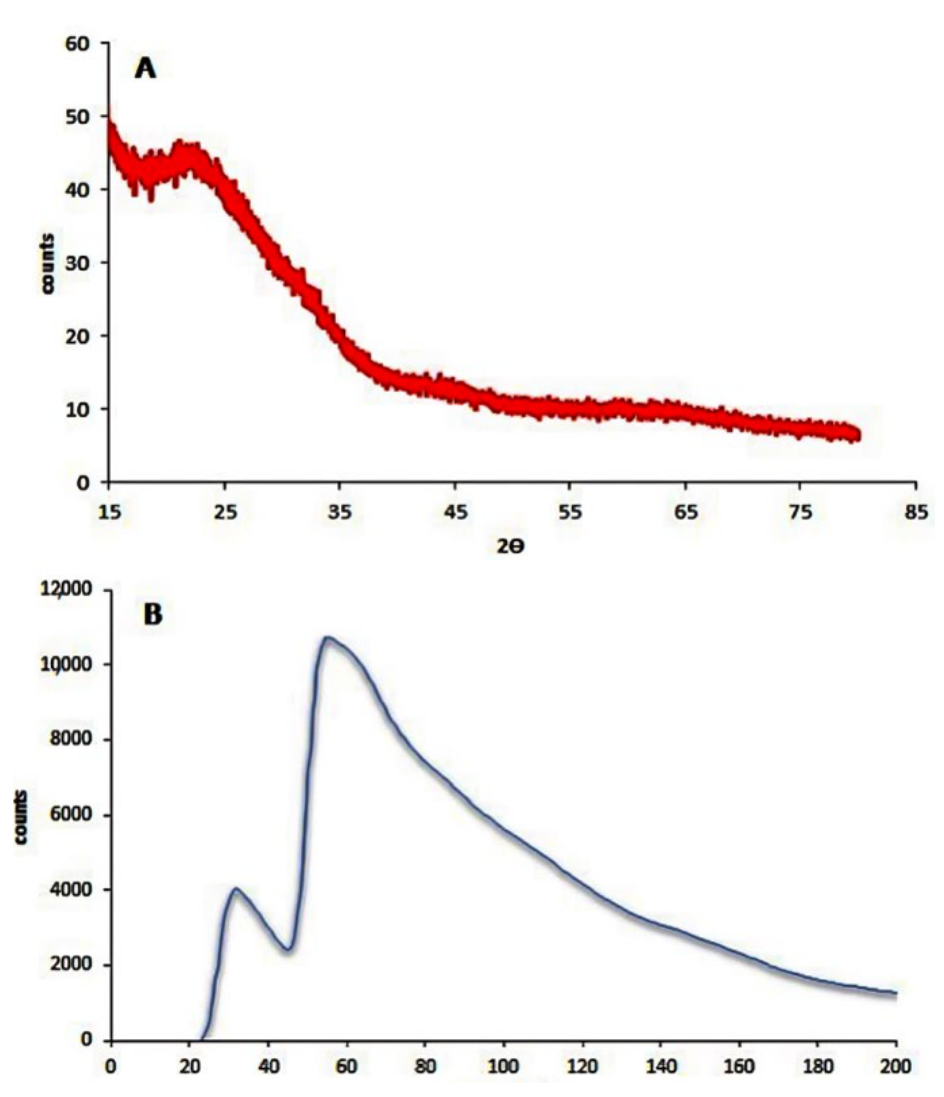
Figure 1. ( A ) XRD pattern of silver nanoparticles and ( B ) Raman spectra.